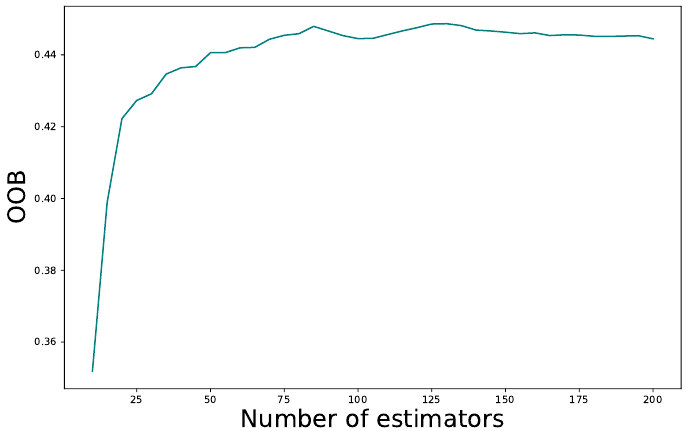
Figure 4. OOB score vs. number of estimators.